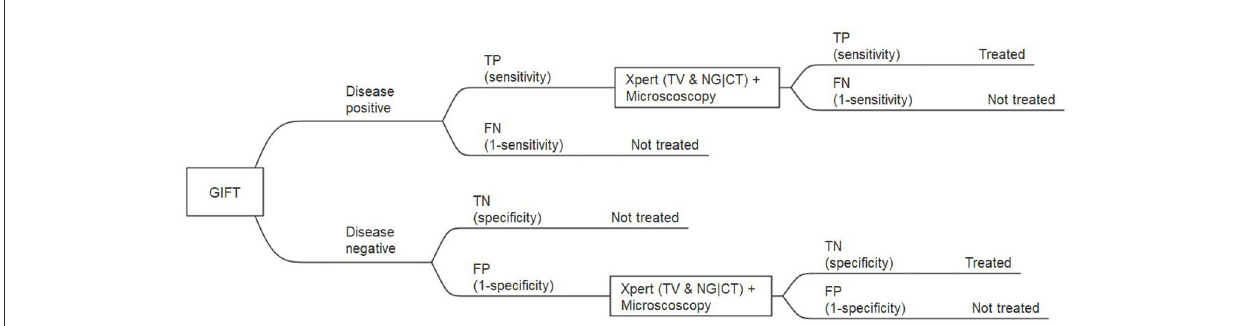
FIGURE1 Extract from the full decision tree: GIFT, followed by GeneXpert and microscopy for GIFT positive, subtree. TP, true positive; FP, false positive; TN, true negative; FN, false negative.